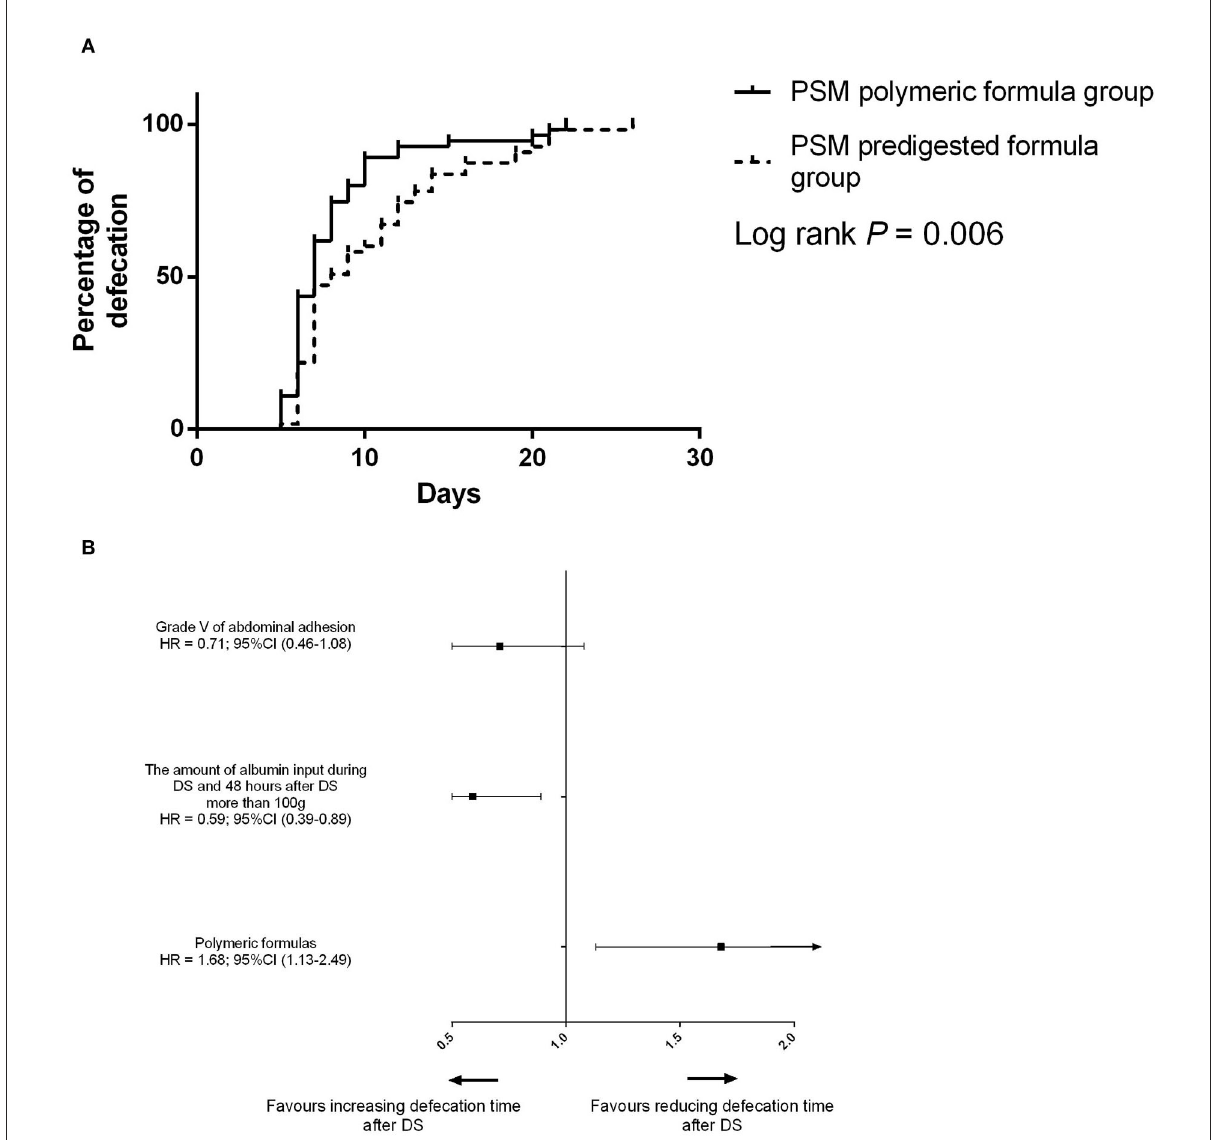
FIGURE4 (A) Difference of the defecation time between the PSM predigested formula group and PSM polymeric formula group. (B) Risk factors for defecation after PSM.